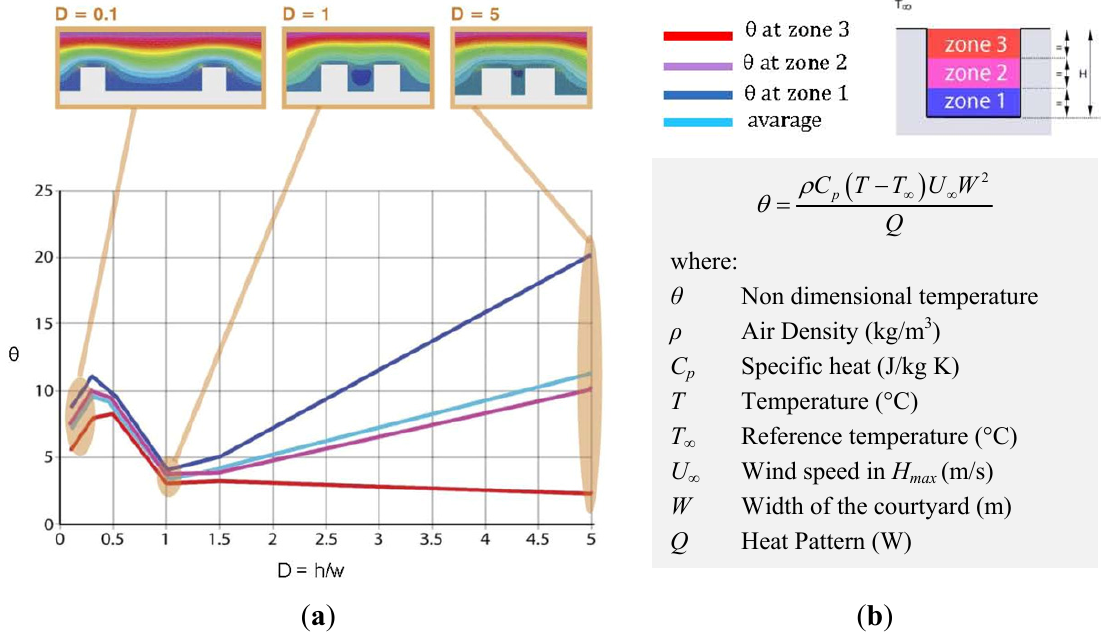
Figure 7. ( a ) Graphic of the non dimensional temperature related to the depth ratio of the courtyard as a heat source at three different heights. Three different flow patterns are shown for D = 0.1, D = 1, D = 5 which correspond with changes of non dimensional temperature. The four lines represent θ at three different heights in the courtyard and the average temperature of the whole courtyard; ( b ) Non dimensional temperature formula when the courtyard acts as a thermal source